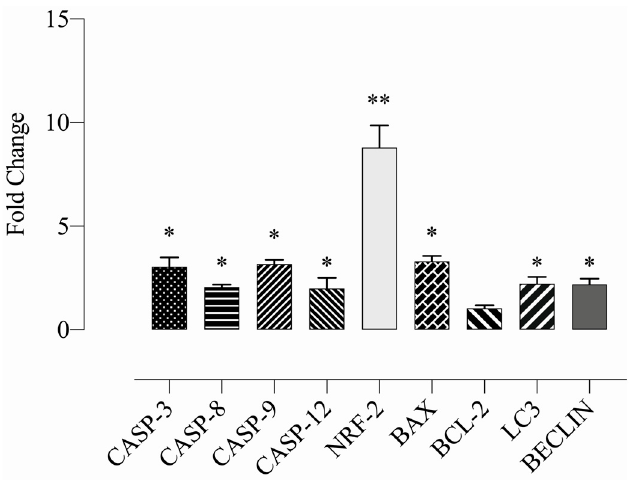
Figure 9. Measurement of the relative apoptotic gene expressions. A 25 µM dose of compound E , inhibited CAIX and dramatically increased the expressions of apoptosis (caspase-3, caspase-8, caspase-9, caspase-12 and Bax) and autophagy mediators (LC3, Beclin) and ROS-related genes (NRF-2). The data are presented as the mean ± SD (n = 3). * p < 0.05; ** p < 0.01 compared with the control.